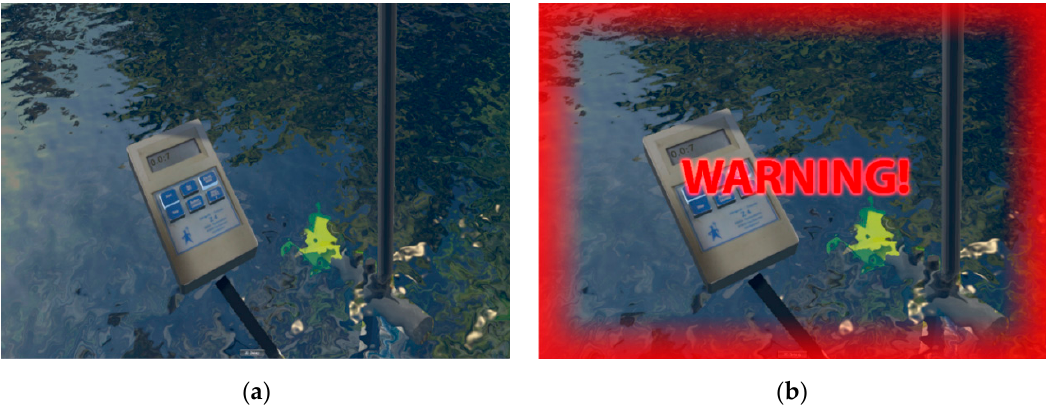
Figure 7. ( a ) An abandoned instrument in the water and ( b ) a warning message.